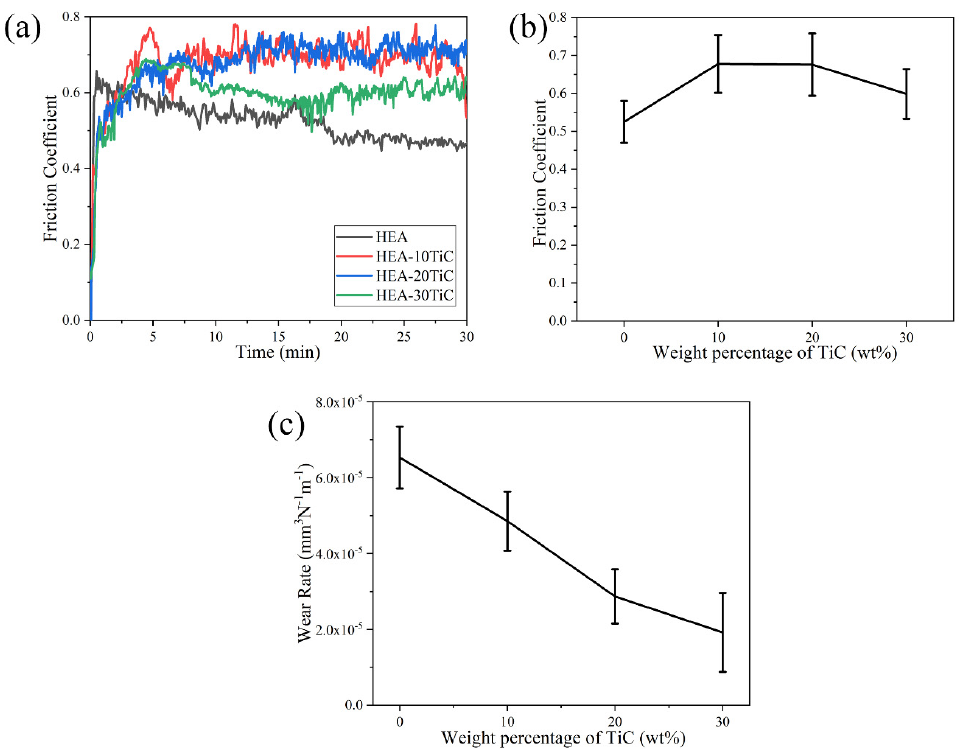
Figure 7. ( a ) Friction coefficient vs. sliding time. ( b ) Friction coefficient vs. TiC content. ( c ) Wear rate of HEA-TiC composites at room temperature.